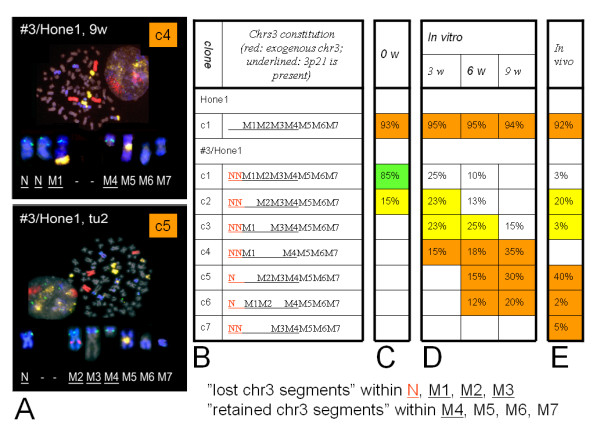
Clonal changes in Hone1 and derived MCH #3/Hone1. A. Four-probe FISH determines the chr3 constitution (see explanation to figure 2C) for #3/Hone1 samples taken at 9 weeks of in vitro propagation (c4) and in SCID tumor 2 (c5). B. Chr3 constitution for each clone. N- normal chr3; red specifies the exogenous chromosome; black are endogenous Hone1 derived markers, M1, M2 ... M7. Underlined: RP6-123I13 signal is present. C-E. Percentages of metaphases representing a particular clone at 0, 3, 6 and 9 weeks of propagation and in all SCID tumors analyzed. Orange, yellow and green shading: expanded clones with no, 1 and 2 supernumerary 3p21 copies, respectively, compared to Hone1. The term "expanded clone" refers to a clone that appeared at the given time or its representation was not decreased (ratio >0.8) compared to the previous time point. No shading: decreased representation from previous time point. Empty: clone is not present in the sample. Note that chr3 fragments, which were carried by N, M1, M2 and M3, were lost in more than one clone expanded during growth ("lost chr3 segments"), whereas ones included into M4, M5, M6 and M7 were never lost ("retained chr3 segments").